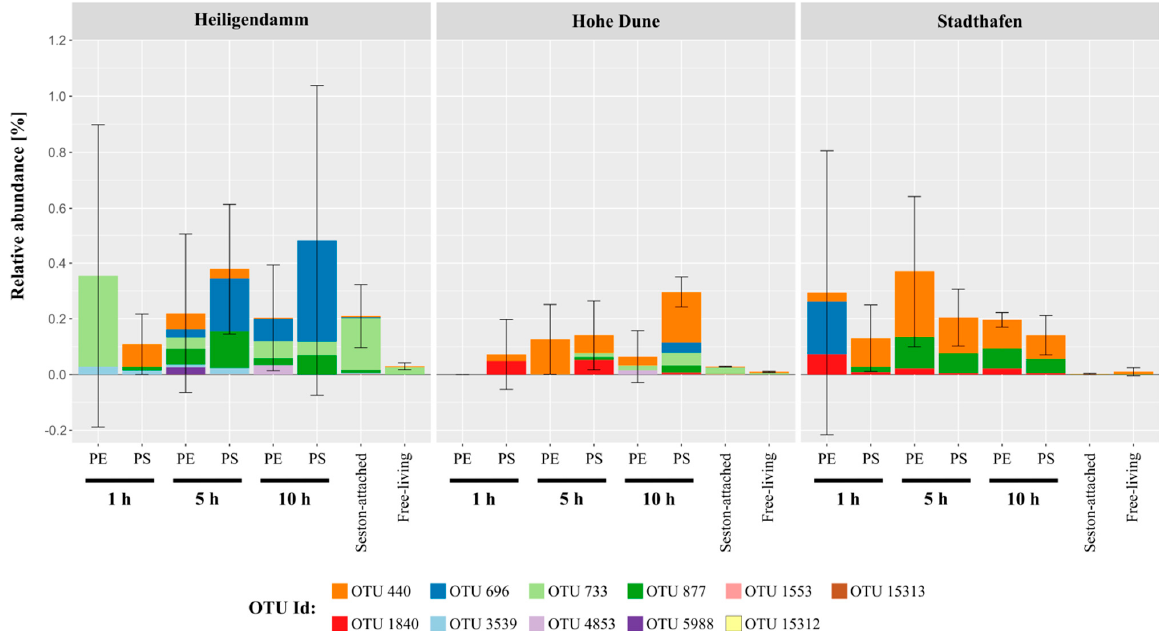
Figure 2. Mean relative abundance data of Vibrio operational taxonomic units (OTUs) on PE, PS, and water during an in situ incubation experiment covering the Warnow river (Stadthafen) and two Baltic Sea coastal station (Heiligendamm and Hohe Dune). Plastic samples were taken after 1, 5, and 10 h. Vibrio abundances within the water were fractionated into those on the seston-attached fraction (>3 µ m) and in the free-living fraction (3–0.22 µ m). Colors indicate different Vibrio OTUs based on 97% sequence similarity. Error bars give the standard deviation (SD) of the mean aggregated Vibrio abundances.